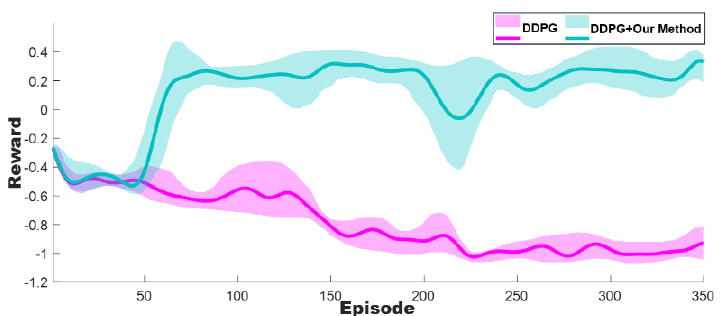
Figure 9. Learning curves comparison for rewarding methods.